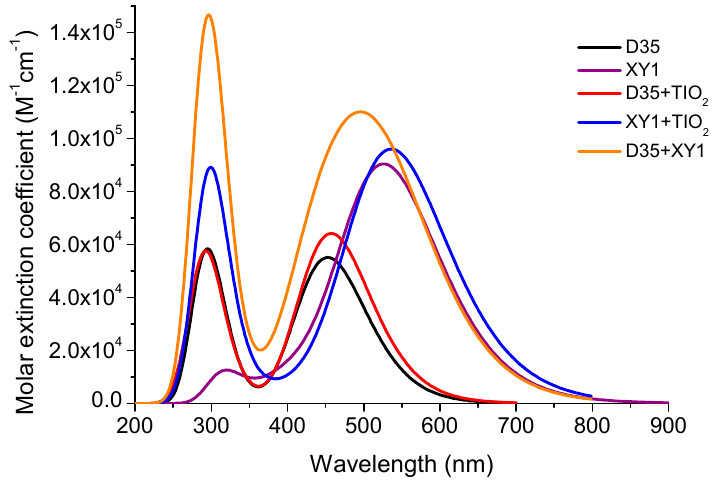
Figure 3. Simulated spectra for the dye in acetonitrile solvent, adsorption on TiO 2 and cosensitization.